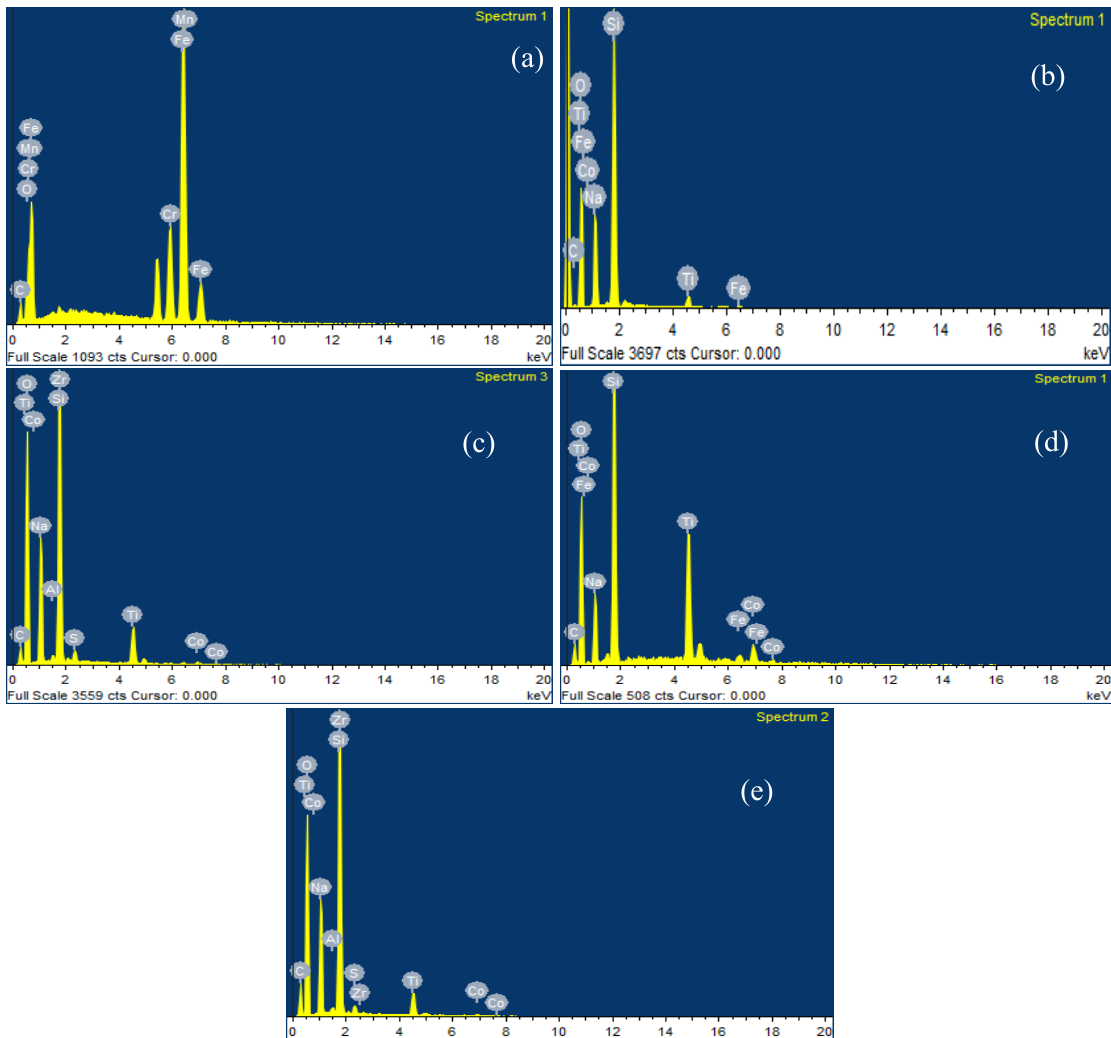
Figure 3. EDS patterns of ( a ) Uncoated wire ( b ) Co 3 O 4 /TiO 2 coated wire before test ( c ) 8 wt.% ZrO 2 ‐ Co 3 O 4 /TiO 2 coated wire before test ( d ) Co 3 O 4 /TiO 2 coated wire after test ( e ) 8 wt.% ZrO 2 ‐ Co 3 O 4 /TiO 2